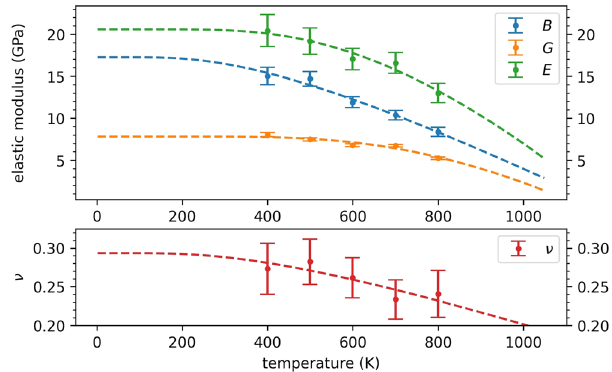
Fig. 6 Temperature dependence of B , G , E, and ν for t-LGPS from NPT CP molecular dynamics at 400, 500, 600, 700, and 800 K. The error bars are the standard errors of the moduli over the trajectories, after a block analysis as from Fig. 3. The computed data are fi tted to the Wachtman ’ s equation (Equation (2) and refs. 74 – 76 ). An analogous plot for o-LGPO is reported in Supplementary Figure